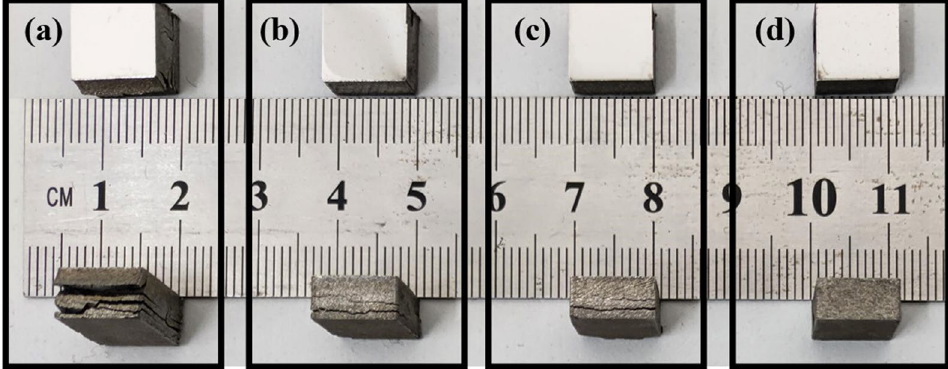
Figure 12 Side crack of cube specimens at different substrate temperatures: a 100 ℃ , b 150 ℃ , c 200 ℃ , d 250